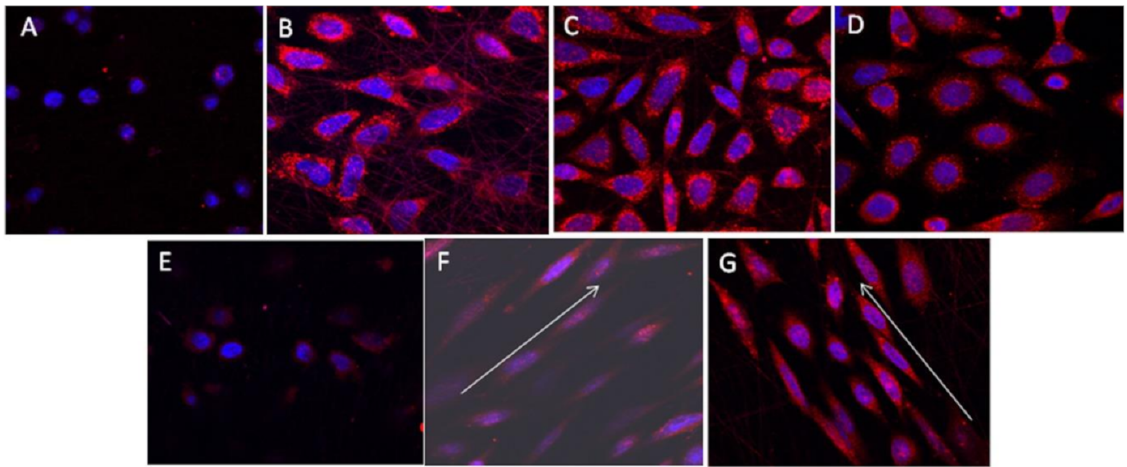
Figure 13. Expression of NF200 by cells seeded on random ( A ) PHBV, ( B ) PHBV/Col75:25, ( C ) PHBV/Col50:50; ( D ) TCP; and aligned nanofibers of ( E ) PHBV, ( F ) PHBV/Col75:25, and ( G ) PHBV/Col50:50. Reproduced from [14] with permission from